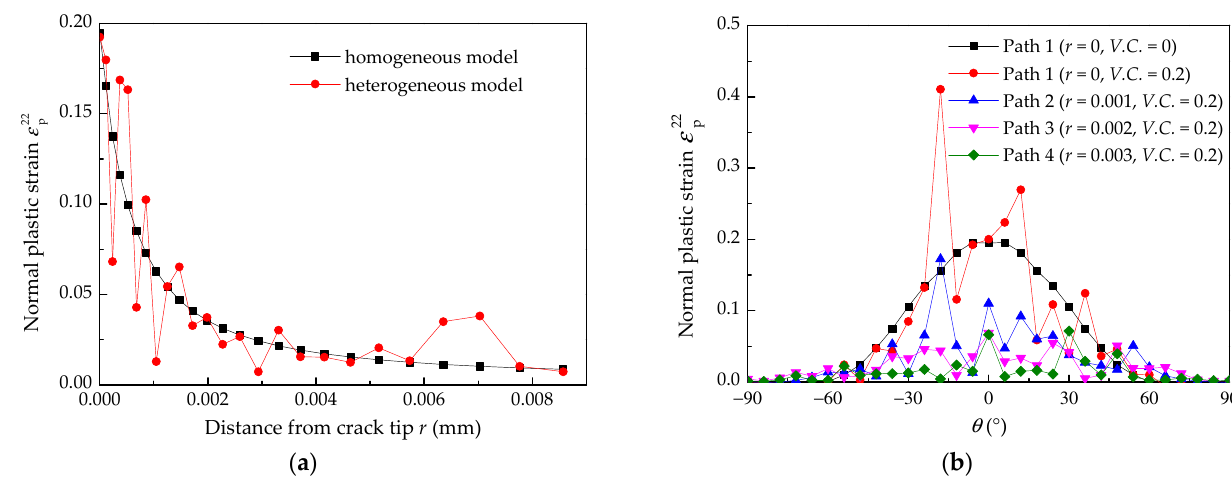
Figure 7. Normal plastic strain under homogeneous and heterogeneous conditions: ( a ) in front of the crack tip; ( b ) around the crack tip.